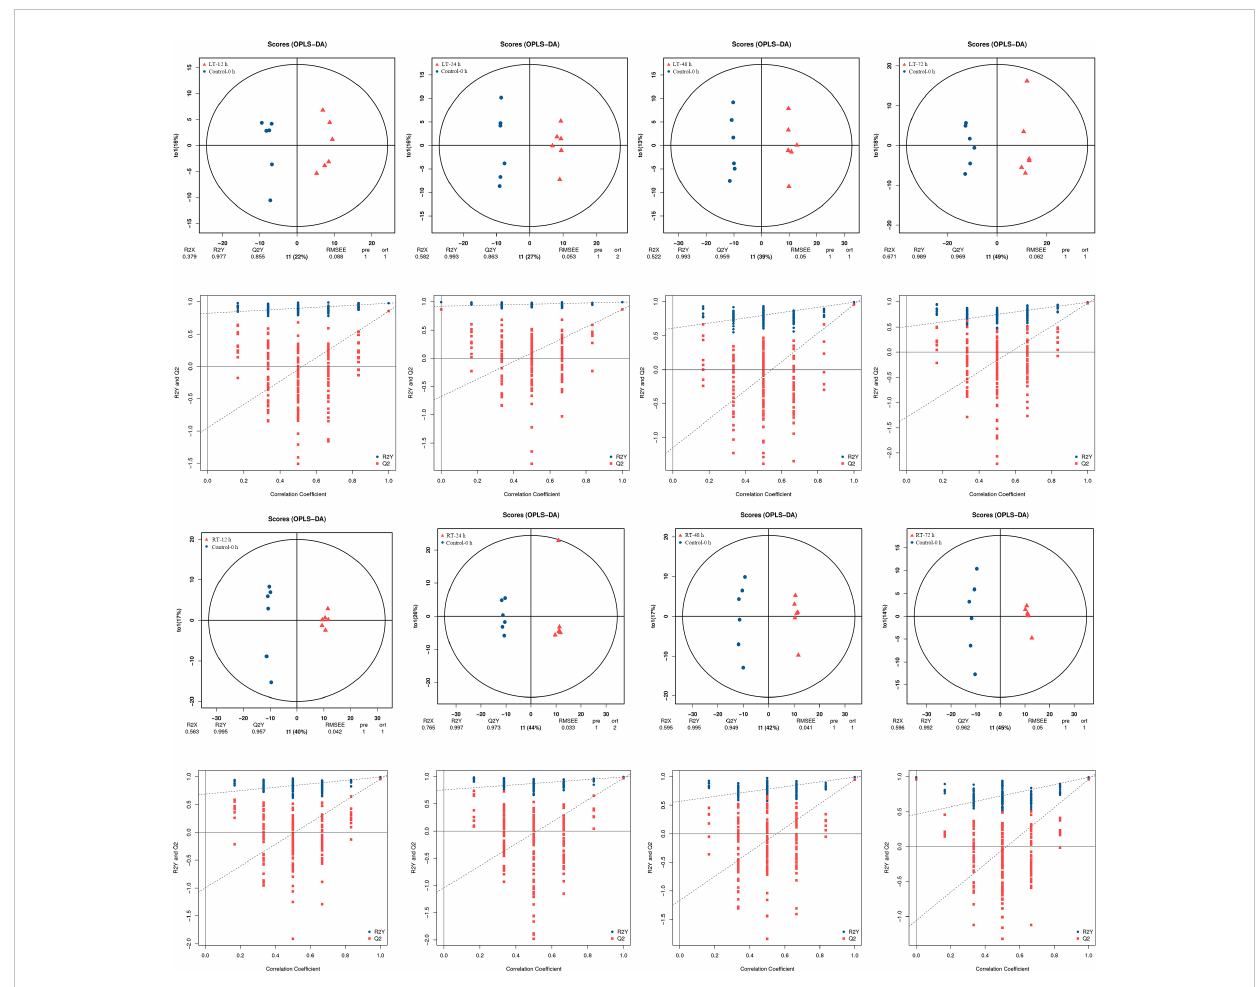
FIGURE 3 Metabolomic analysis of postharvest toon buds using GC-TOF-MS, including the OPLS-DA plots of RT, LT-stored samples, and control (top fi gure). Performance of the permutation tests validated from the OPLS-DA model (bottom fi